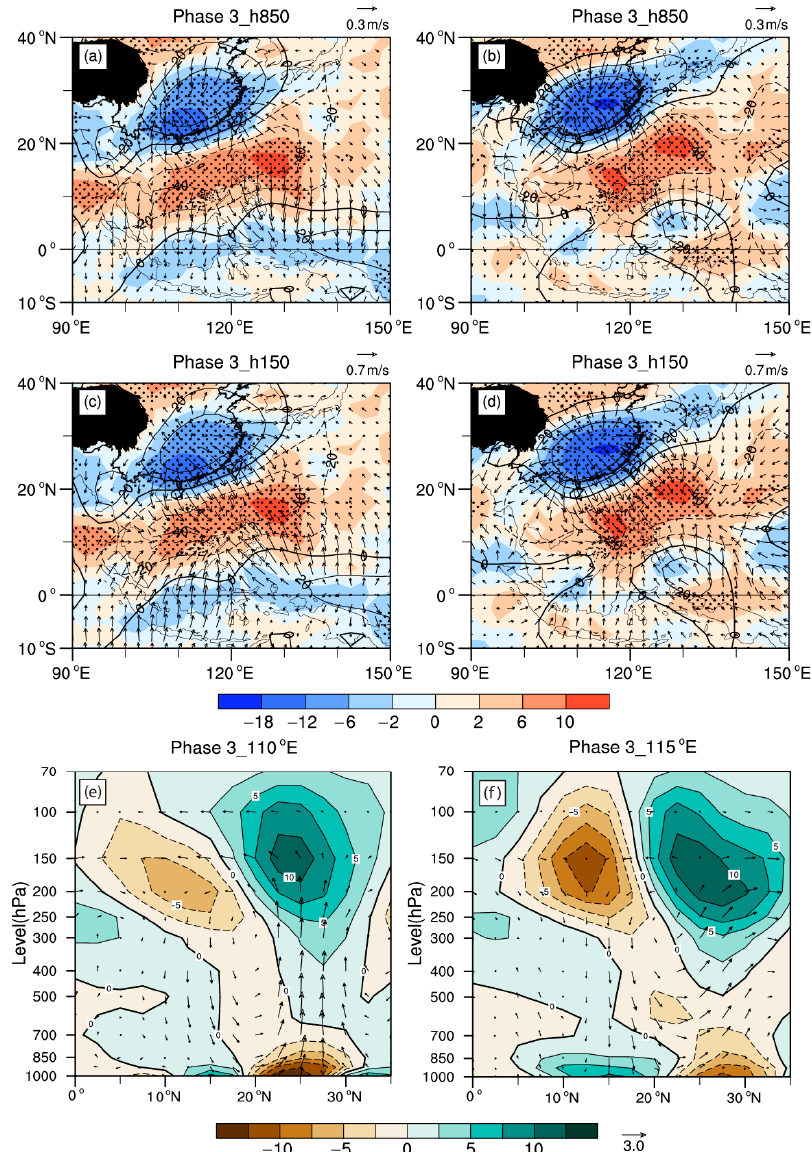
Figure 5. Composite of the 850 hPa ( a , b ) and 150 hPa ( c , d ) LF outgoing longwave radiation (OLR) fields of 10–20 days (shaded, W/m 2 , dotted areas are significant at α = 0.1 level), LF whole-layer integrated atmospheric apparent heat source <Q 1 > (contours, W/m 2 ), LF divergent wind field (vector, m/s), LF meridional circulation along 110° E ( e ) and 115° E ( f ) (vector, vertical velocity, − 10 − 2 Pa/s; meridional wind, m/s) and LF divergence field (shaded, 10 − 5 m/s 2 ) latitude–altitude profile based on the LF precipitation of 10–20 days at the peak of phase 3 in flood ( a , c , e ) and drought ( b , d , f ) years. The black area represents the masking of the Tibetan plateau.